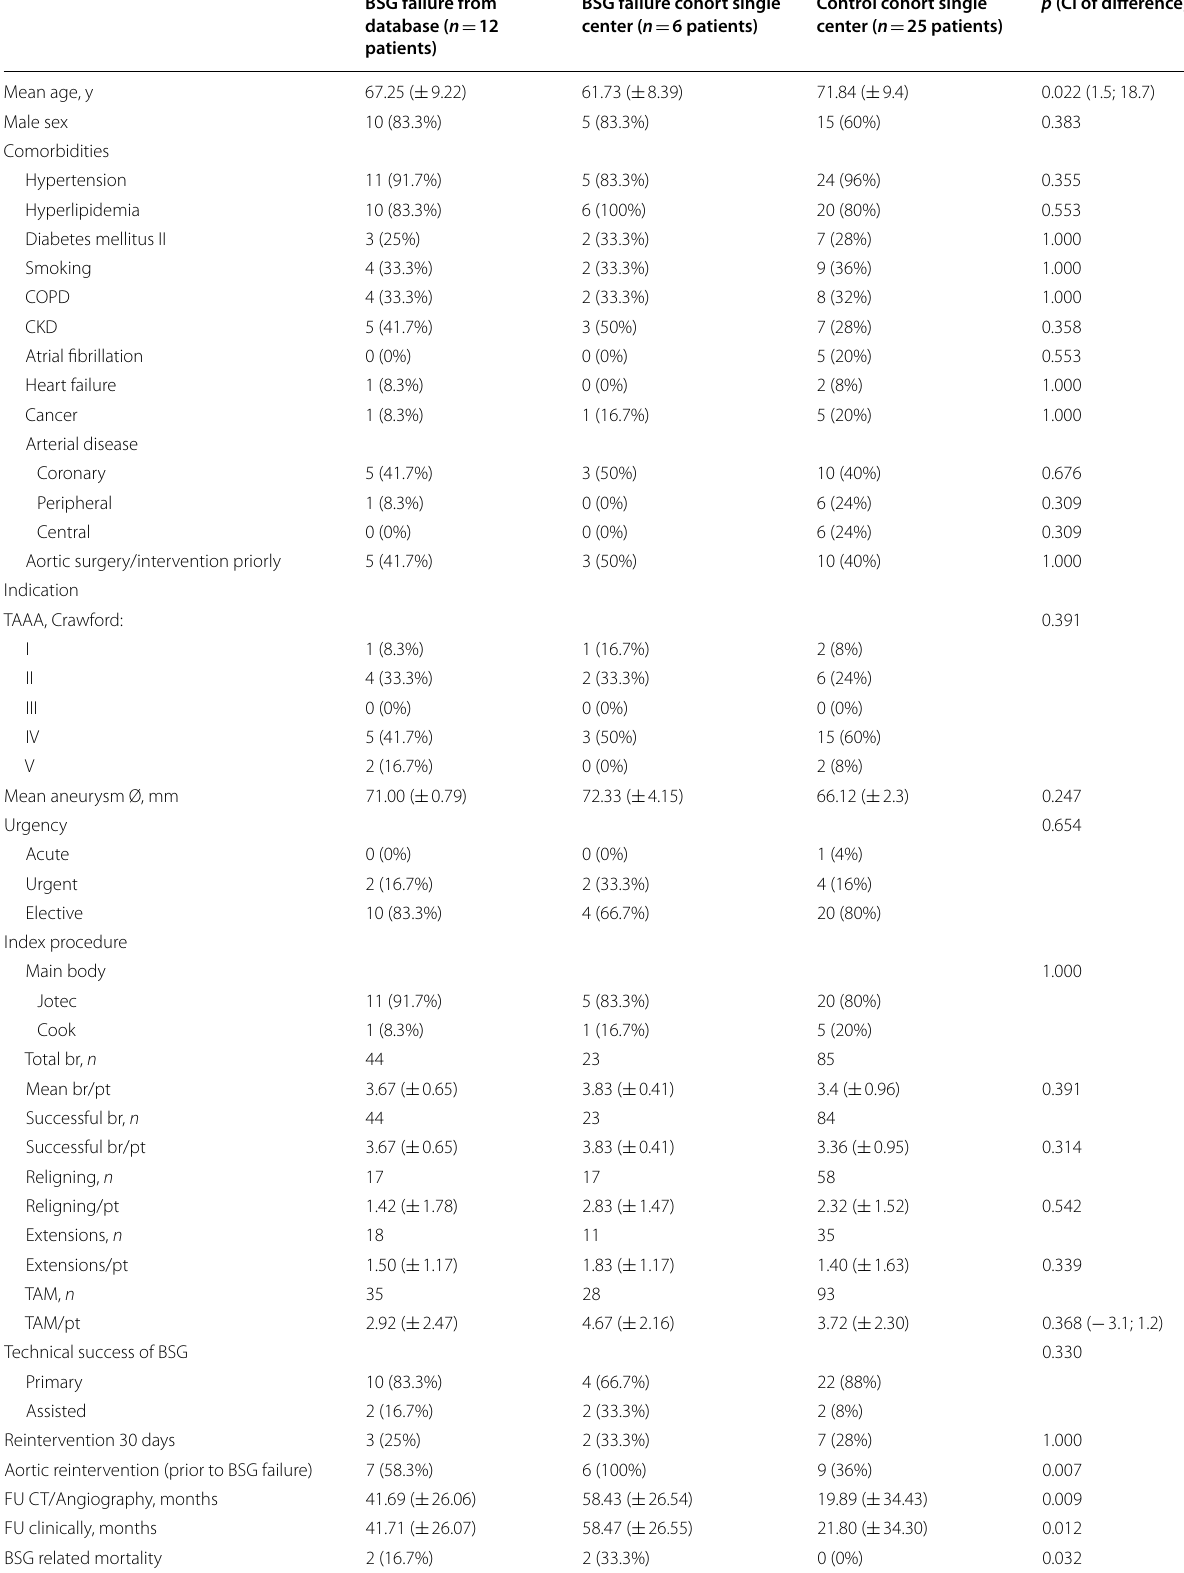
Table 1 Baseline demographic and clinical characteristics of study